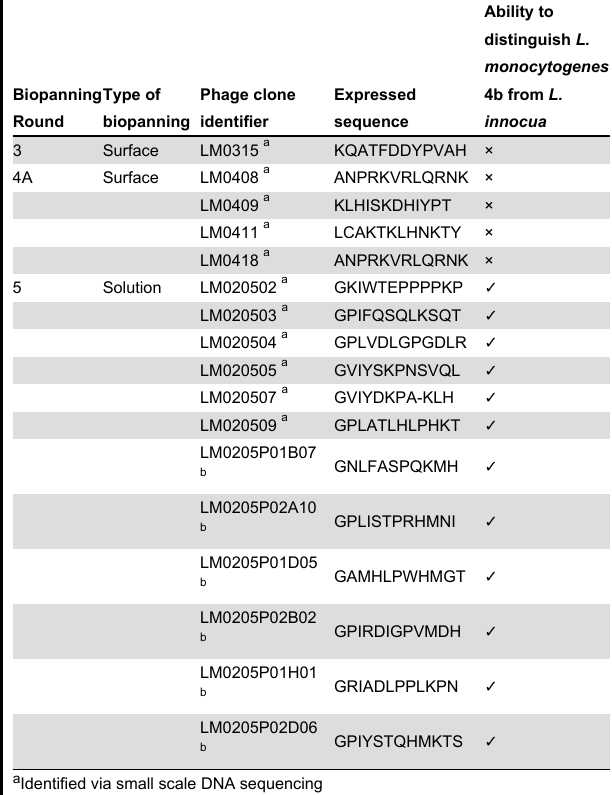
Table 4. Information on phage clones from biopanning rounds 3, 4A and 5 chosen for further evaluation in terms of specificity for L. monocytogenes 4b by phage binding